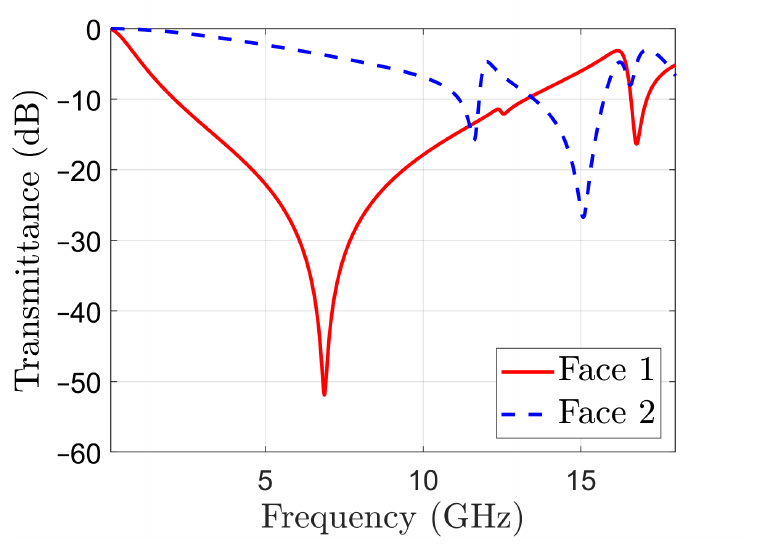
Figure 3. Transmittance in normal incidence of periodic surfaces with metal patterns on one face only, as in Figure 1: Face 1 solid line; Face 2 dotted